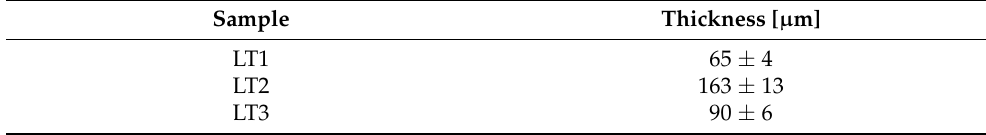
Table 6. Thickness of the obtained surface layers for individual